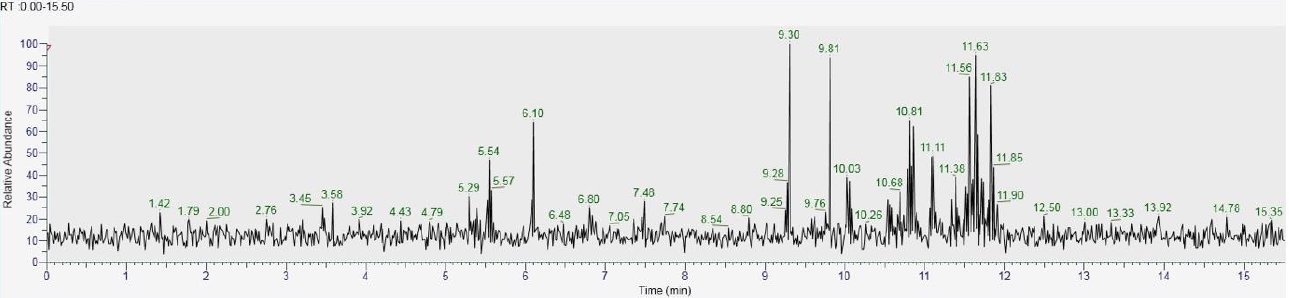
Figure 18. GC-MS/MS chromatogram of Hericium erinaceus. Table 3. GC-MS/MS analysis of Hericium erinaceus.